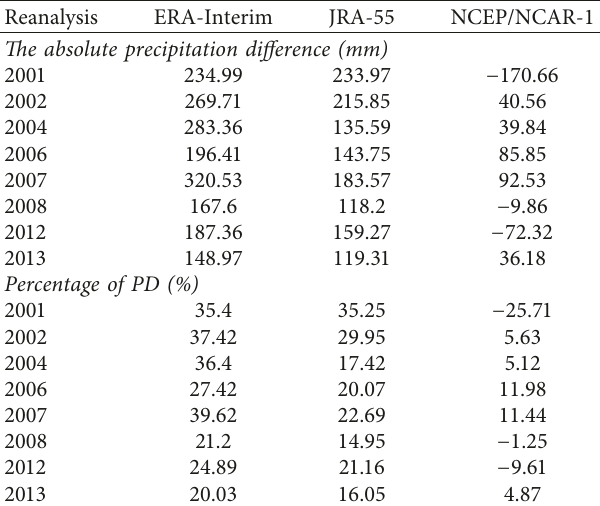
Table 6: The PDs and PPDs between ERA-Interim, JRA-55, and NCEP/NCAR-1 and observed precipitation for the dry